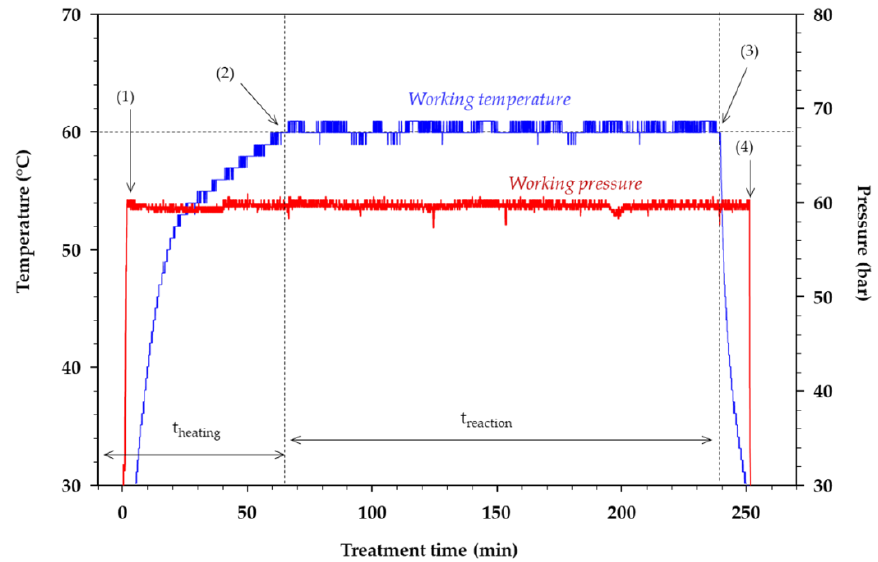
Figure 3. Representative temperature-pressure history during the one-pot conversion of lactose. Reaction temperature was 60 °C and pressure was 60 bar. t heating —heating time (min), and t reaction — reaction time (min). Arrows (1–4) represent the start of pressurization, the beginning of the reaction time, the end of the reaction time, and the depressurization, respectively.